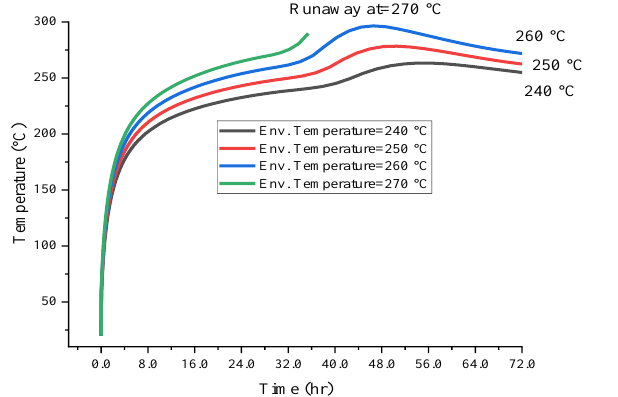
Figure 7. Simulation results of critical temperature for [BZMIM][TF2N] with 25.0 g box packages.